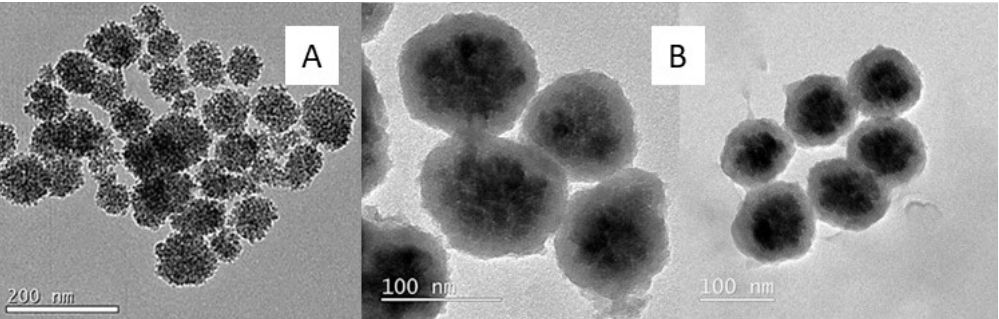
Figure 8. ( A ) Transmission micrographs of Fe 3 O 4 nanoparticles synthesized by the solvothermal method. ( B ) Transmission micrographs of mMIP in organic medium ( left ) and mMIP in aqueous medium ( right ).